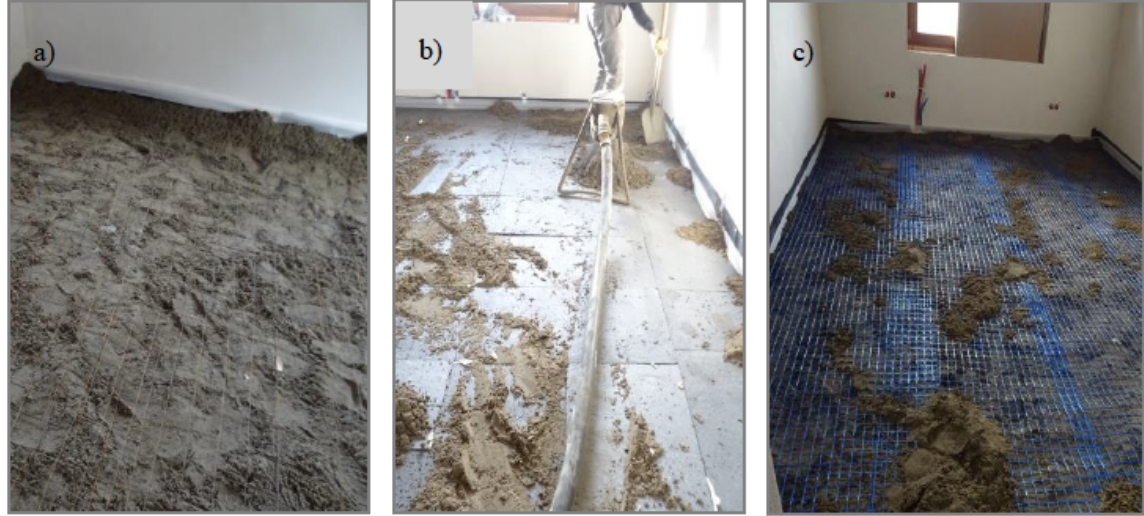
Figure 2: Pictures of performed construction works: a) room R-S (steel mesh reinforcement), b) room R-PF (reinforced with polypropylene fibres), c) the room R-G (fibreglass mesh reinforcement).